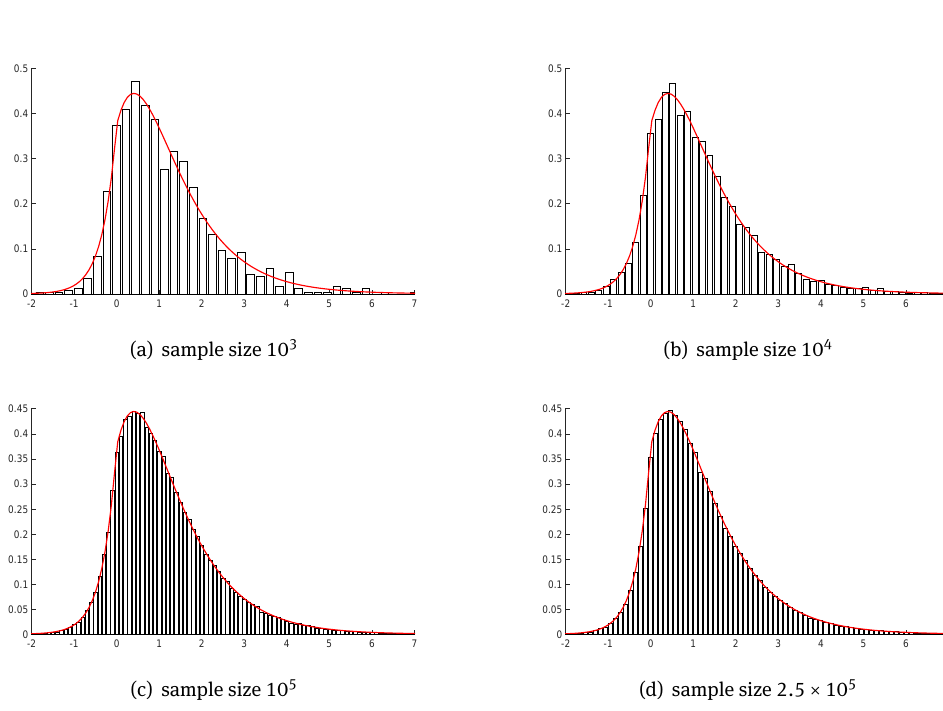
Figure 2: Maximum pdf f 3:3 and histogram for p = 1 , increasing sample sizes and dg g (3)